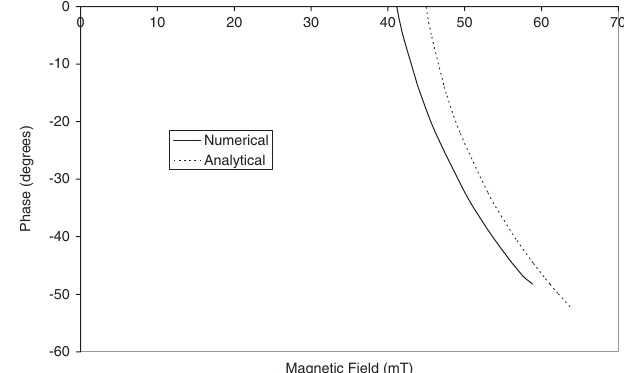
FIG. 5. Launch phase of resonant electron trajectories as a function of peak magnetic field for a 70 mm radius iris and rf frequency of 800 MHz.